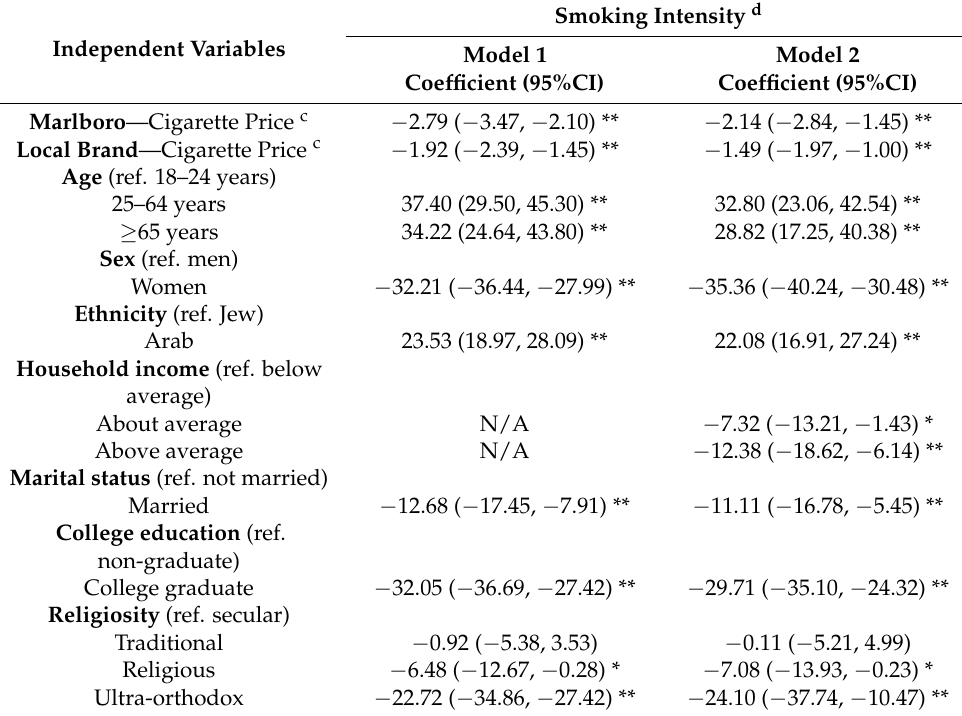
Table 4. Cigarette Prices and Smoking Intensity among Adult Smokers in Israel a : OLS regression b